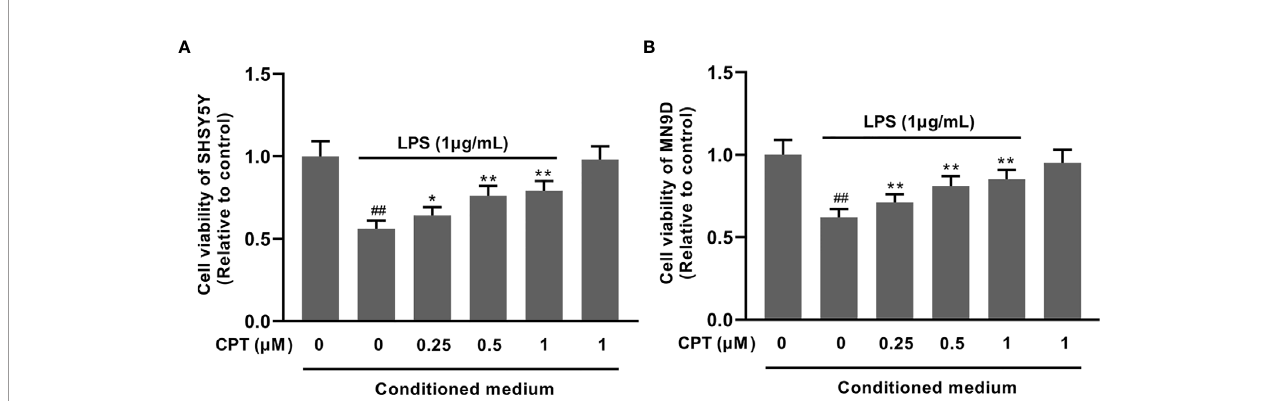
FIGURE 8 | CPT exerts a neuroprotective effect in SHSY5Y and MN9D cells by regulating the polarization of microglia. The SHSY5Y and MN9D cells were cultured with the conditioned medium for 18 h. The viability of the SHSY5Y (A) and MN9D (B) cells was measured using CCK-8. Results are shown as means ± SD (n= 5).